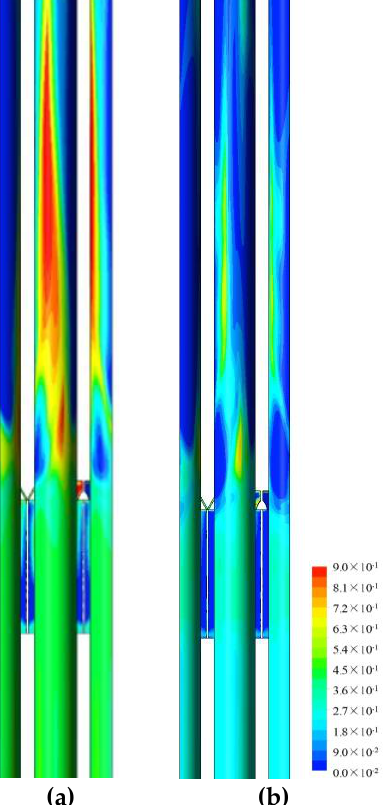
Figure 6. Vapor fraction on the rod surface: ( a ) case 1, ( b ) case 1.